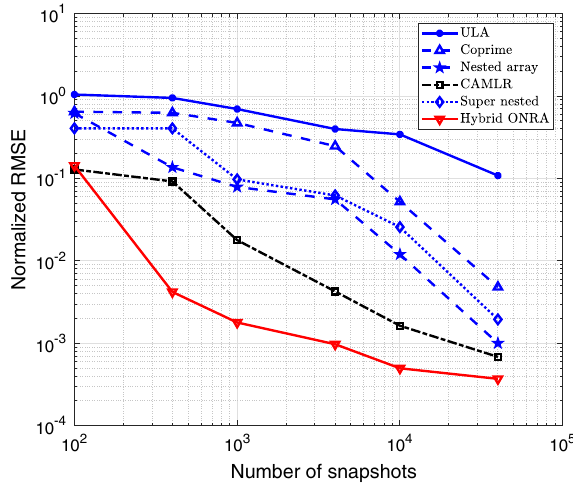
Fig. 4 RMSE of the CU-RIS channel versus the number of snapshots when the paths are closely spaced (transmit power